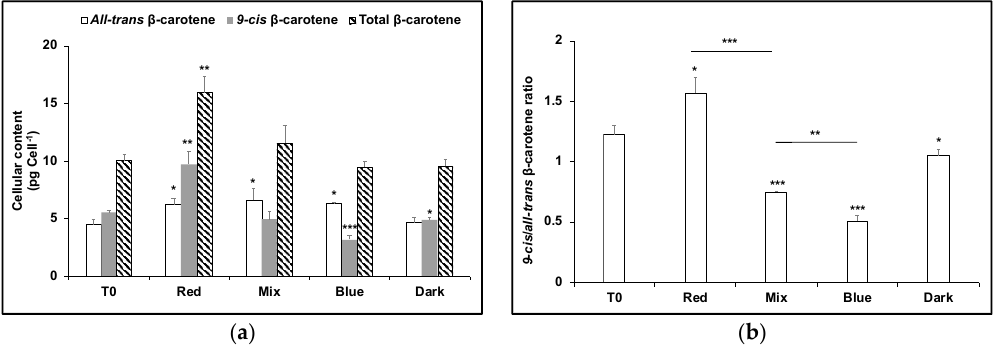
Figure 2. ( a ) Cellular content of 9-cis β C and all-trans β C and ( b ) 9-cis / all-trans β C ratio in D. salina cultures exposed to continuous red LED light at 1000 µmol m − 2 s − 1 for 24 h followed by 24 h under either red light, a mix of 1:1 red and blue light, blue light at the same light intensity of 1000 µmol m − 2 s − 1 or dark. Each culture condition was set up at least in triplicate. Results were analysed by one way analysis of variance (ANOVA) with posterior Dunnett’s test compared to T0 and Tukey multiple pairwise-comparisons. Asterisks represent different levels of significance (*** 0 < p ≤ 0.001, ** 0.001 < p ≤ 0.01, * 0.01 < p ≤ 0.05).